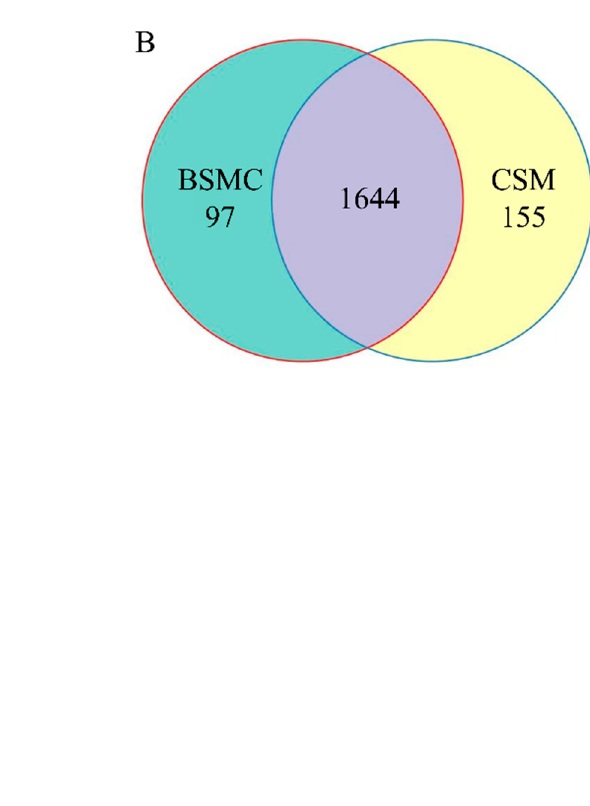
Figure 4. Venn diagram of OTUs among groups. ( A ) OTUs Venn diagram of greenhouse soil microorganisms between BSMC and BSME groups in DC and DF groups; ( B ) BSMC and CSM groups; ( C ) BSME and ESM groups. BSMC: soil microorganisms in the counterpart group before the experiment; BSME: soil microorganisms in the experimental group before the experiment; CSM: soil microorganisms in the counterpart group after the experiment; ESM: soil microorganisms in the experimental group after the experiment.